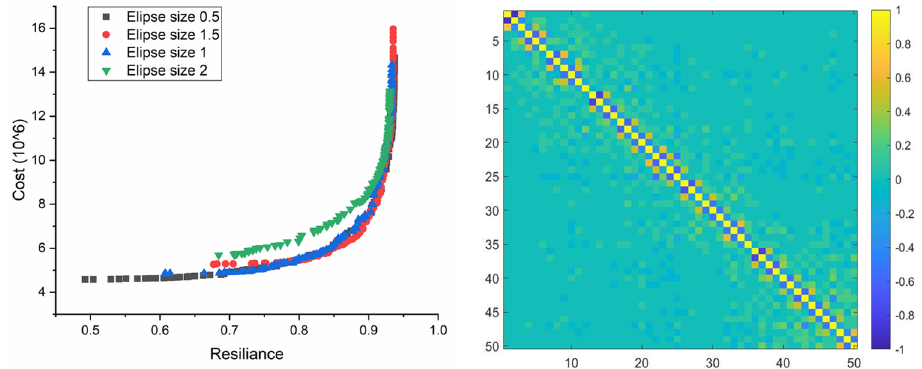
Figure 5. Pareto front obtained for different ellipsoidal sizes with demands related with co-variance matrix (1) shown adjacent.